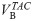
Visual representation of the simulated results using BAFPIC with variable VB.Each vertical line represent the effect of noise for a given range [θmin,
θmax] of the basis function. Noise is expressed as the value of the scale factor in Eq 5. Results in A to D show that bias and CoV of Ki and λk3 depend more on θmin than θmax. In contrast plot E shows that at high noise levels, VB is practically determined by the “high frequency” θmax (simulated VBTAC = 0.05).